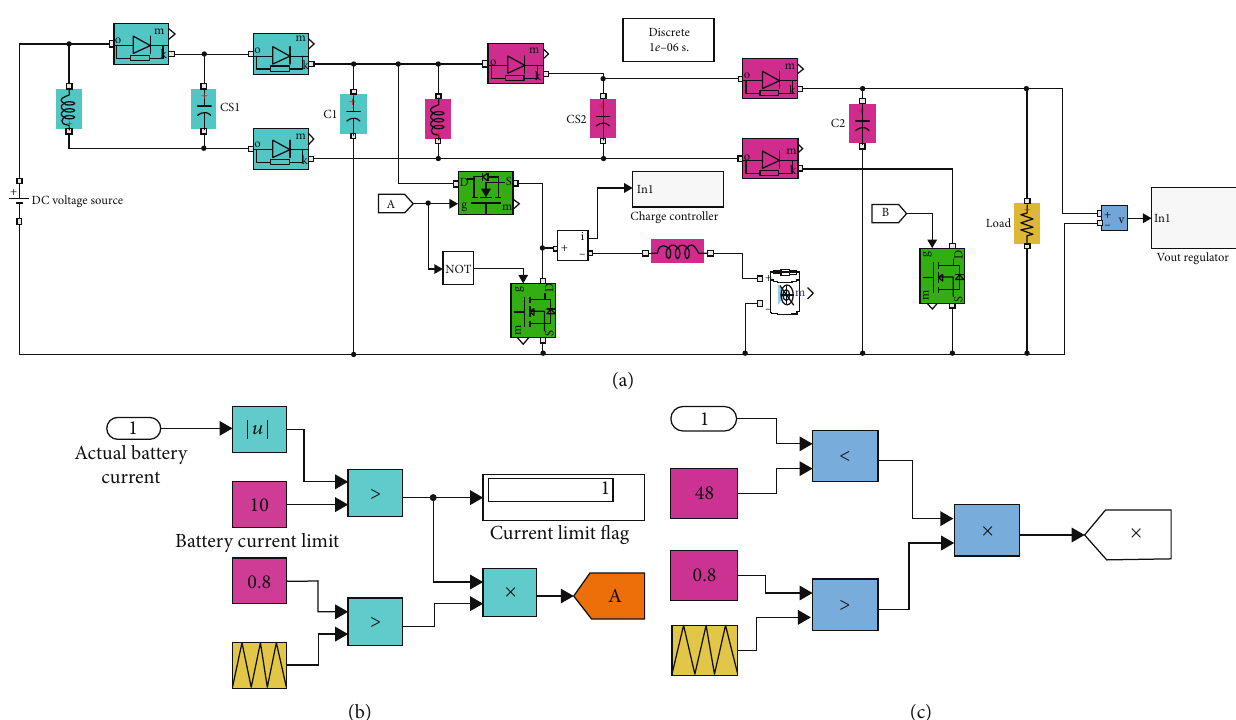
Figure 12: (a) Simulink implementation of the proposed system with a fi xed DC. (b) Battery current regulation scheme. (c) Output voltage regulation